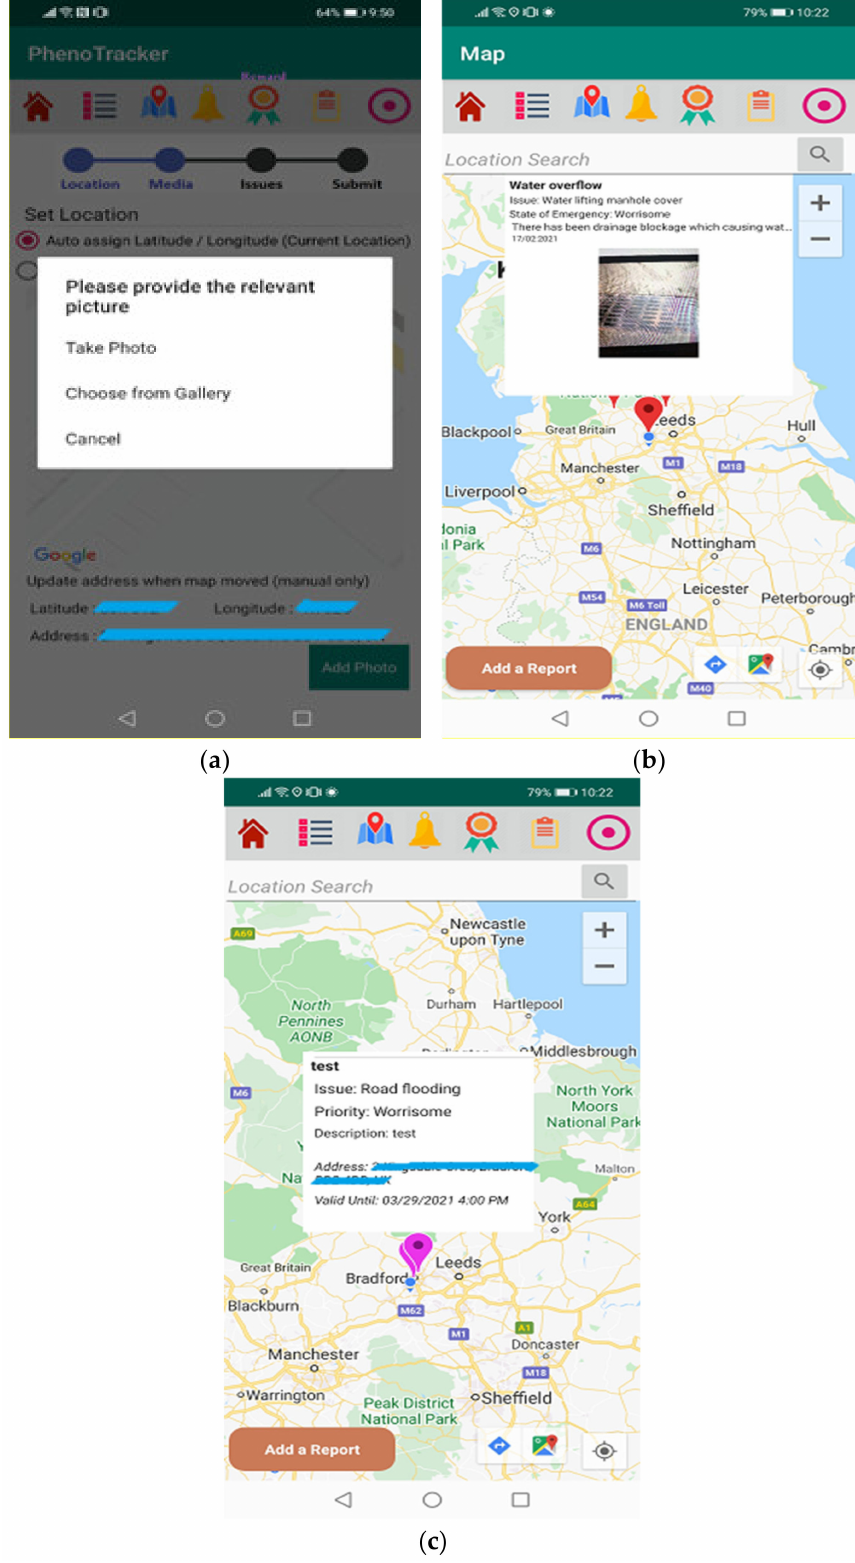
Figure 6. ( a ) Image capture with stored image upload option. Factors covered: Situatedness. ( b ) Report markers on map with brief details of it. Factors covered: Social Bond, Personal Benefit and Curiosity Drive. ( c ) Alert notification with details. Factors covered: Social Bond, Personal Benefit an Curiosity